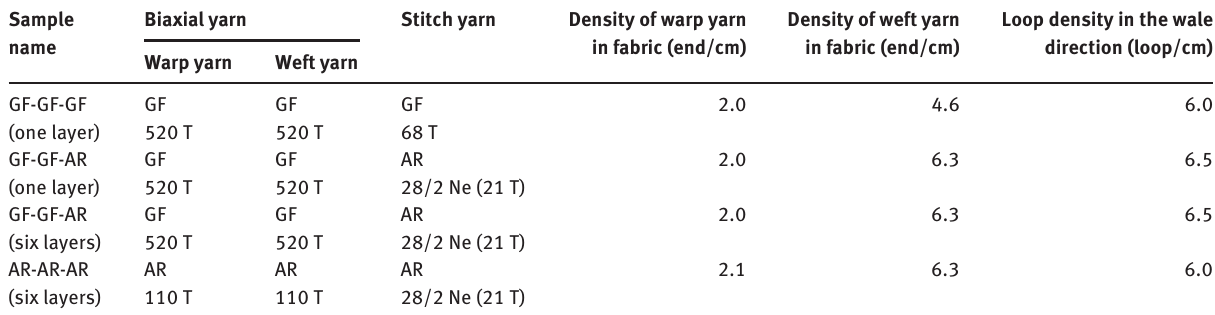
Table 1 Parameters of the BWK